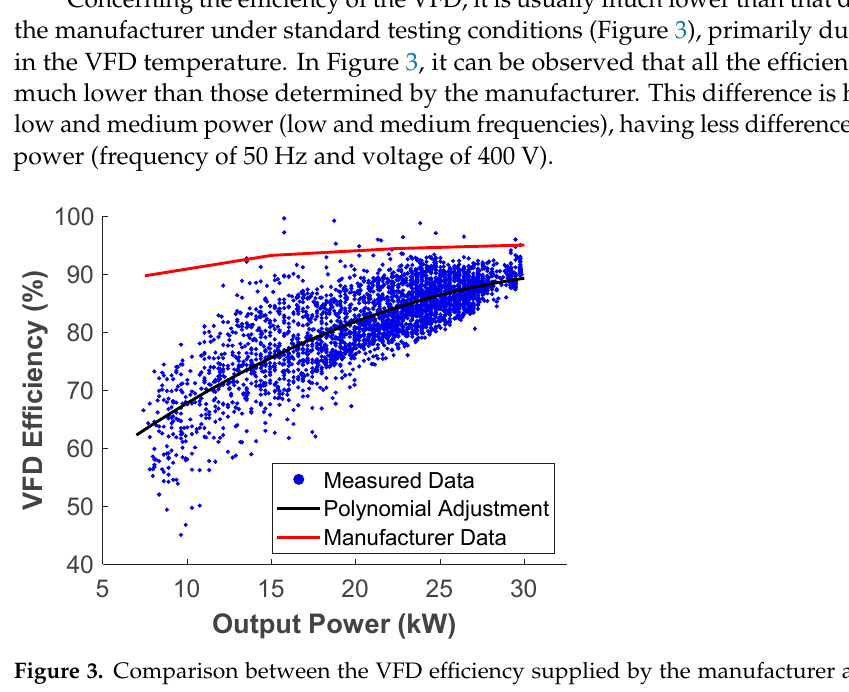
Figure 4. Fitting of the measured power to simulated power using the calibrated parameters. The statistic indicators of the goodness of fit of the simulated vs. measured power can be observed in Table 3. Table 3. Goodness of fit of the calibrated model for the absorbed electric power. RMSE (kW)